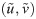
Patient pathology dynamics in secondary tauopathy.(Left) Phase plane (u˜,v˜) with three equilibria. (Right) When three different states co-exist, only the fully toxic state is stable as shown by the time-dynamics plot. (Parameters: a0 = b0 = a1 = a2 = b1 = b2 = 1, a˜1=3/4, b˜1=4/3, b3 = 3). Note that trajectories are initialized by taking the initial condition ϵ = 0.005 away from an equilibrium point.